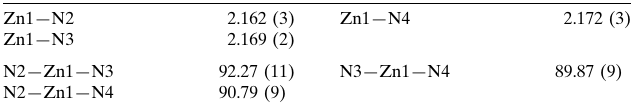
Selected geometric parameters (A˚ , (cid:1)